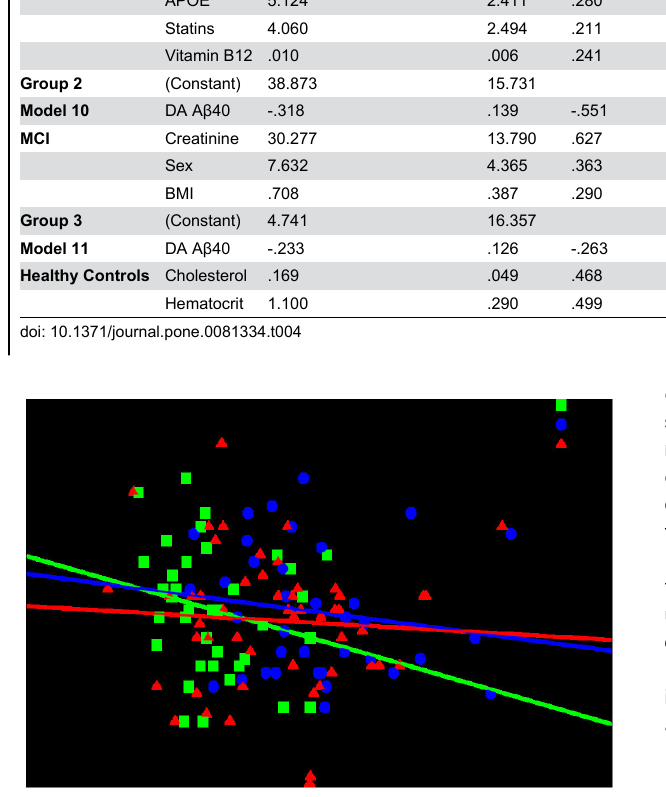
Linear regression between diastolic blood pressure (DBP) volume and levels of DA Aß1-40 in Alzheimer’s disease patients (AD, red triangles), mild cognitive impairment subjects (MCI, blue circles) and healthy individuals (HC, green squares).